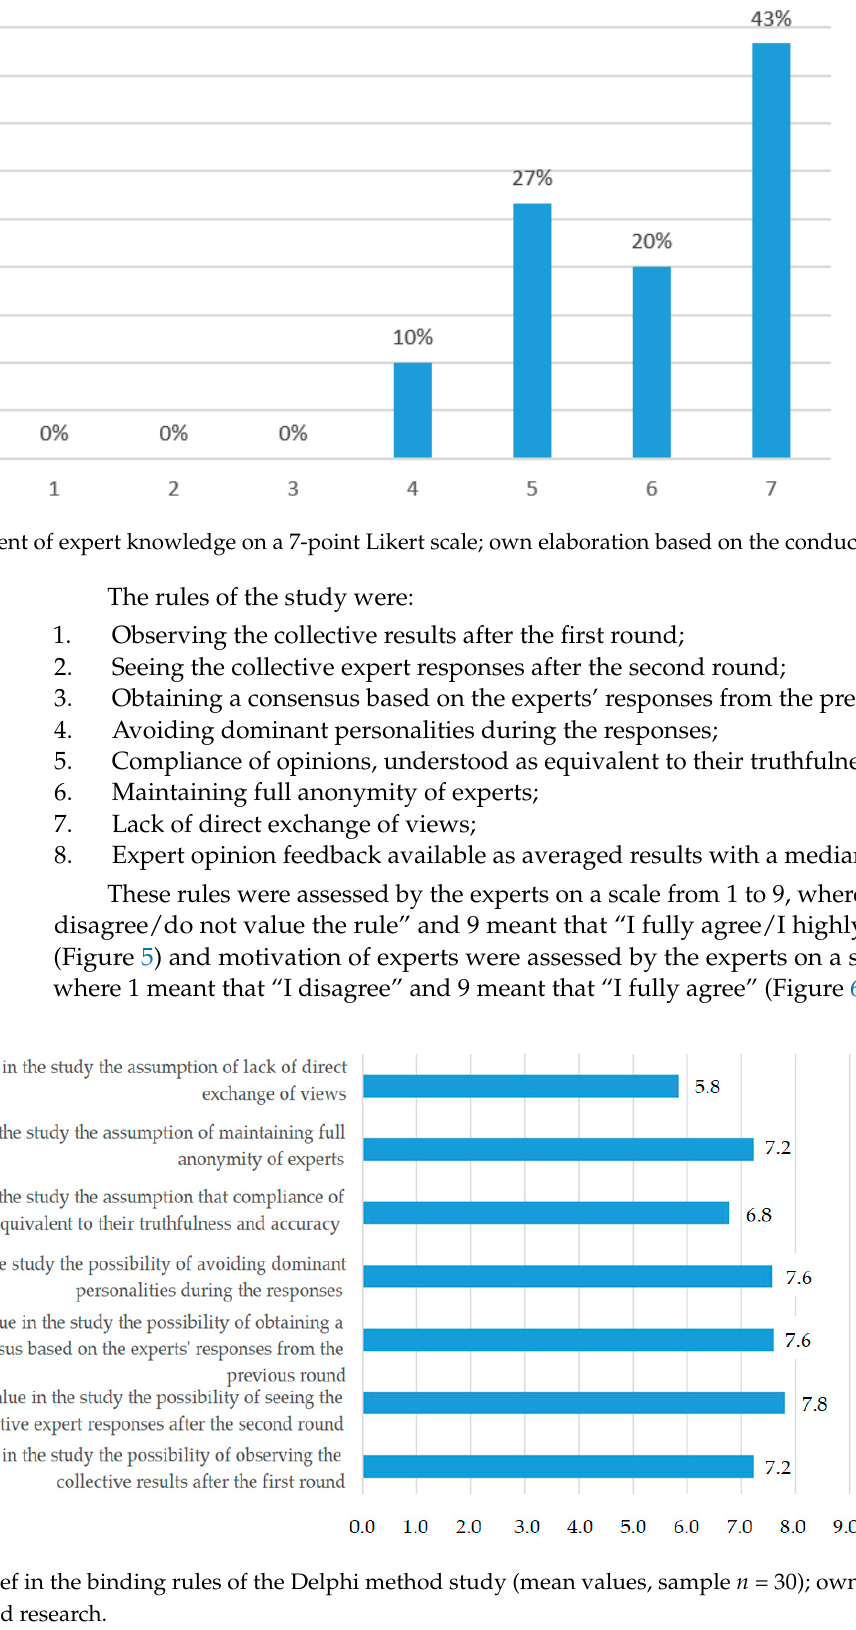
Figure 6. The motivation of experts to take part in the Delphi method study (mean values, sample n = 30); own elaboration based on the conducted research. 4. Research Results Based on the bibliometric analysis using the method of the systematic literature re- view and cluster analysis performed with genetic algorithms, global theoretical trends in supply chains were identified (Table 2; Figures 7 and 8). Table 2. Identified global theoretical supply chain trends, alphabetical order; own elaboration based on the conducted research. No.